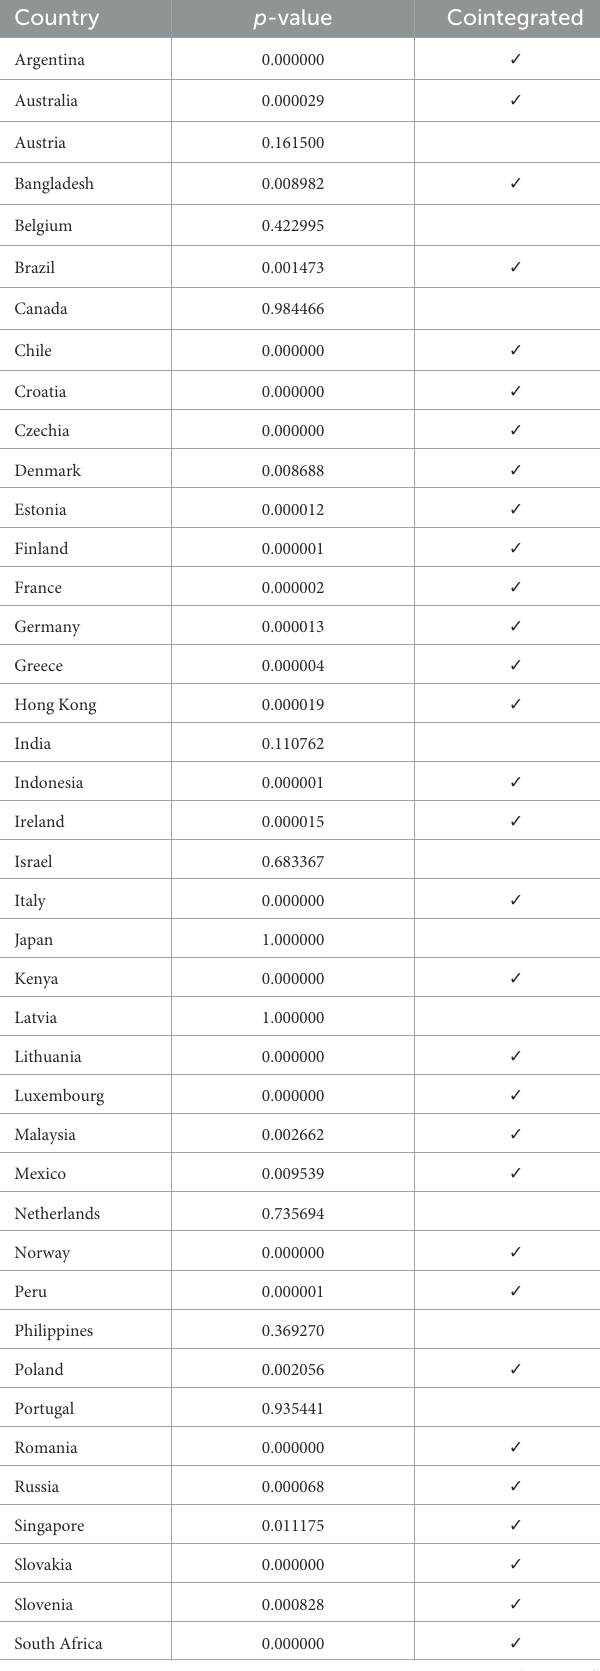
TABLE 1 Stationarity test on cointegration series by country.